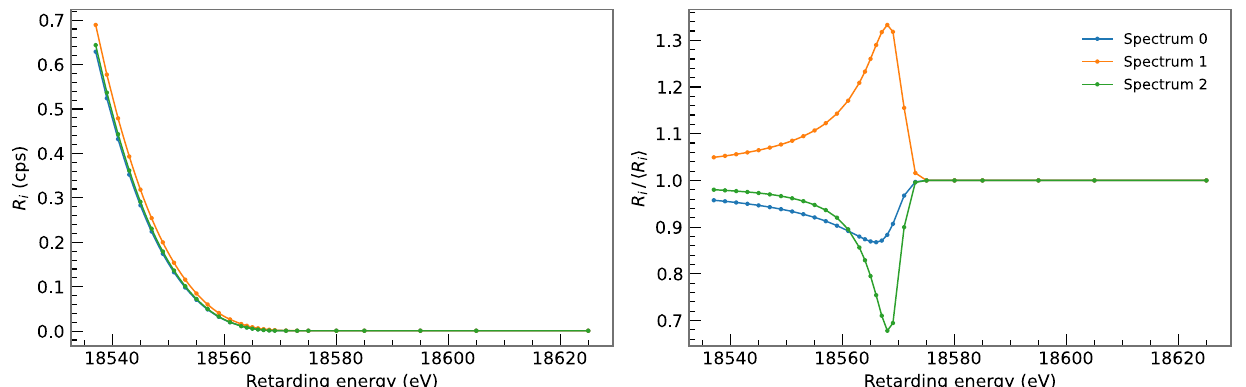
Fig. 2 Left: output spectral rate for different input parameter values θ spec . The spectra all show the same general trend. Right: the output spectra normalized by the average rate in each qU point. We now see clear shape-effects for the different parameter samples. As an exam-